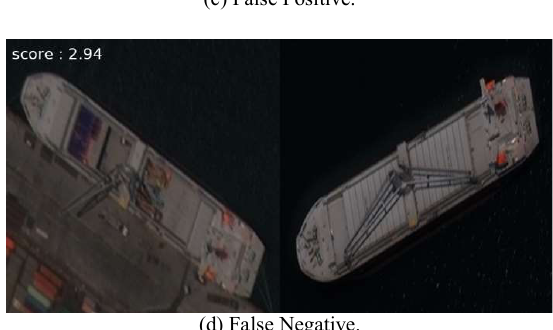
Figure 6. Examples of vessel identification results for our Twin network model from the validation set (best epoch). The identification score d (Euclidian distance between the two images) is show on the top